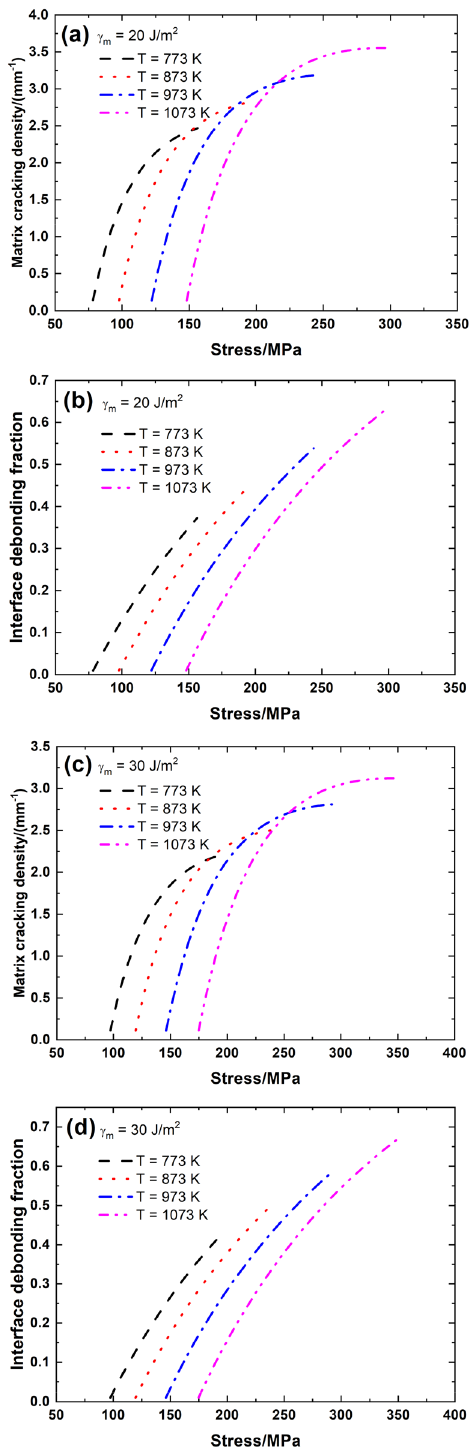
Figure 3: ( a ) The matrix multicracking density versus applied stress curves when γ m = 20 J/m 2 ; ( b ) the interface debonding fraction versus applied stress curves when γ m = 20 J/m 2 ; ( c ) the matrix multicracking density versus applied stress curves when γ m = 30 J/m 2 ; and ( d ) the interface debonding fraction versus applied stress curves when γ m = 30 J/m 2 of C/SiC composites at elevated temperatures of T = 773, 873, 973, and 1,073